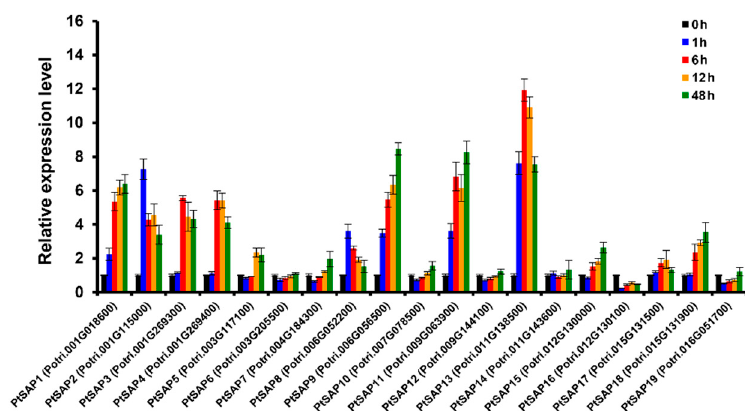
Figure 2. Expression analysis of PtSAP genes under salt stress. The gene expression levels under salt stress were determined using qRT-PCR. Error bars represent the standard deviations of three biological replicates and four technical replicates.